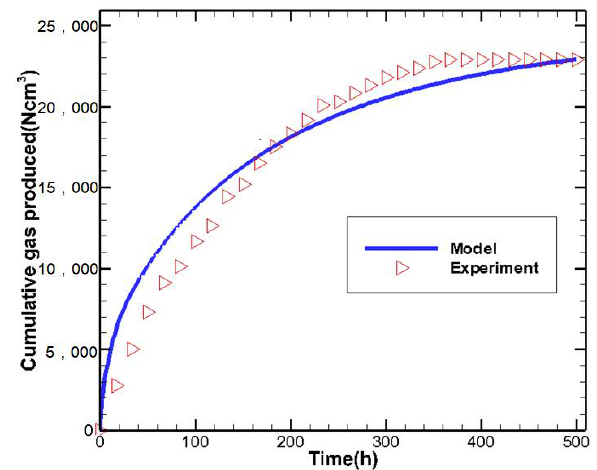
Figure 2. Comparison of the cumulative gas produced from this model and Musuda’s experiment [25].